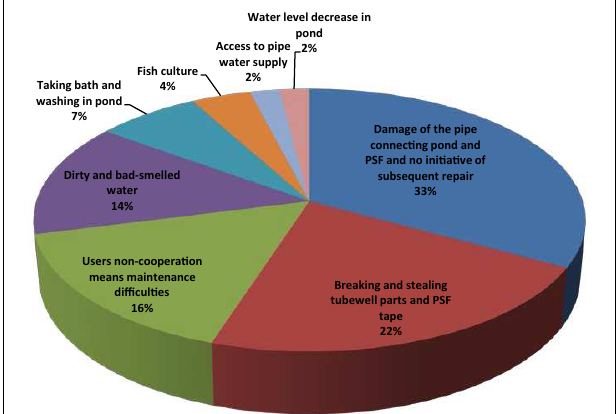
FIGURE 6 | Performance of water options (in terms of percentage of abandonment). FIGURE 7 | Causes of the failure of PSF—respondents’